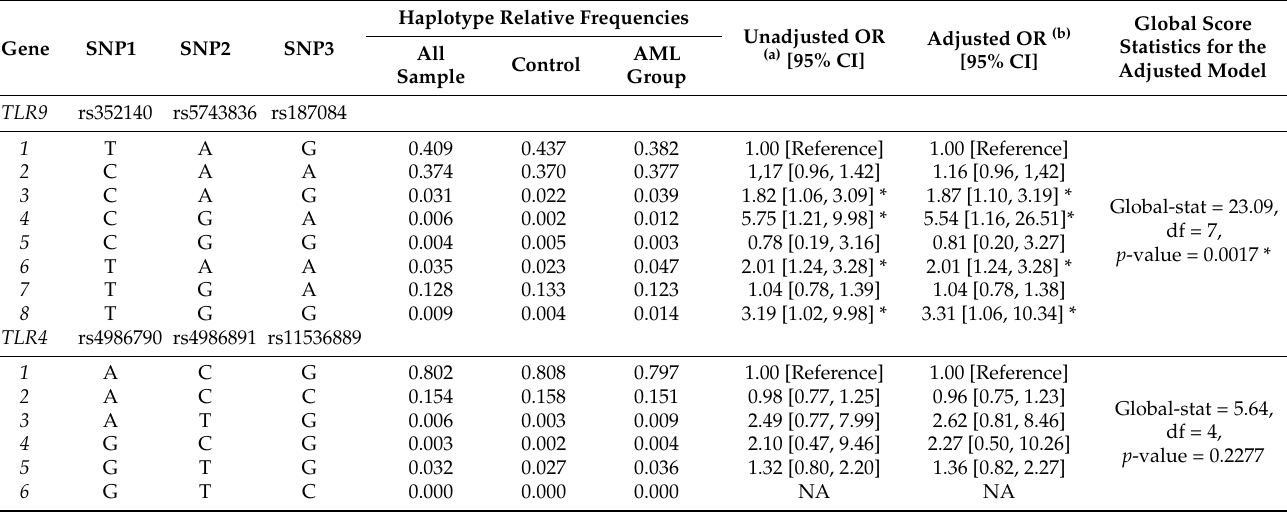
Table 4. Haplotype association analysis between TLR 4 and TLR9 SNPs with AML